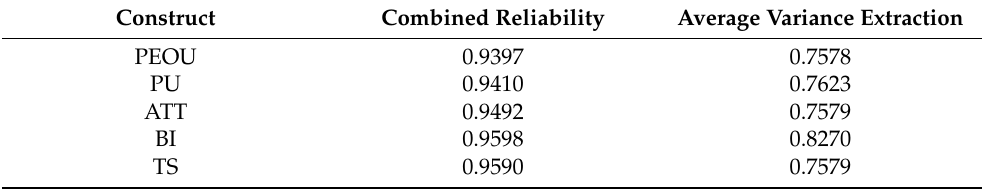
Table 7. Combined reliability and average extraction of variance values for each